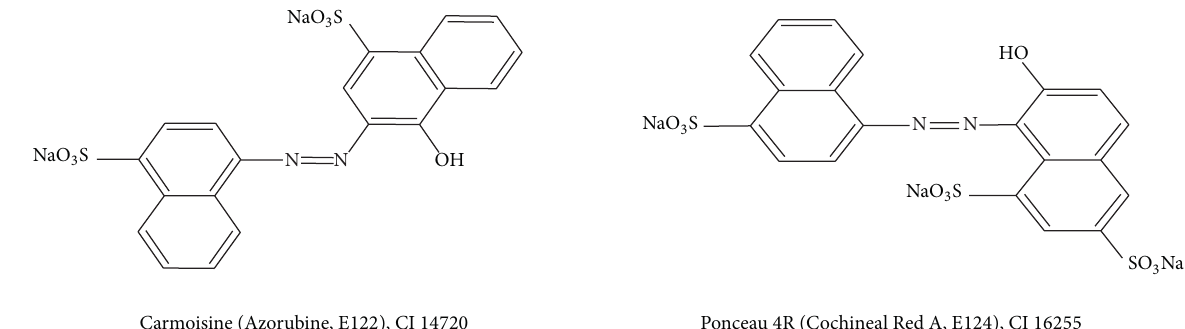
Scheme 1: Chemical structures, common names, European community numbers (E), and color index (CI) numbers of synthetic food colorants